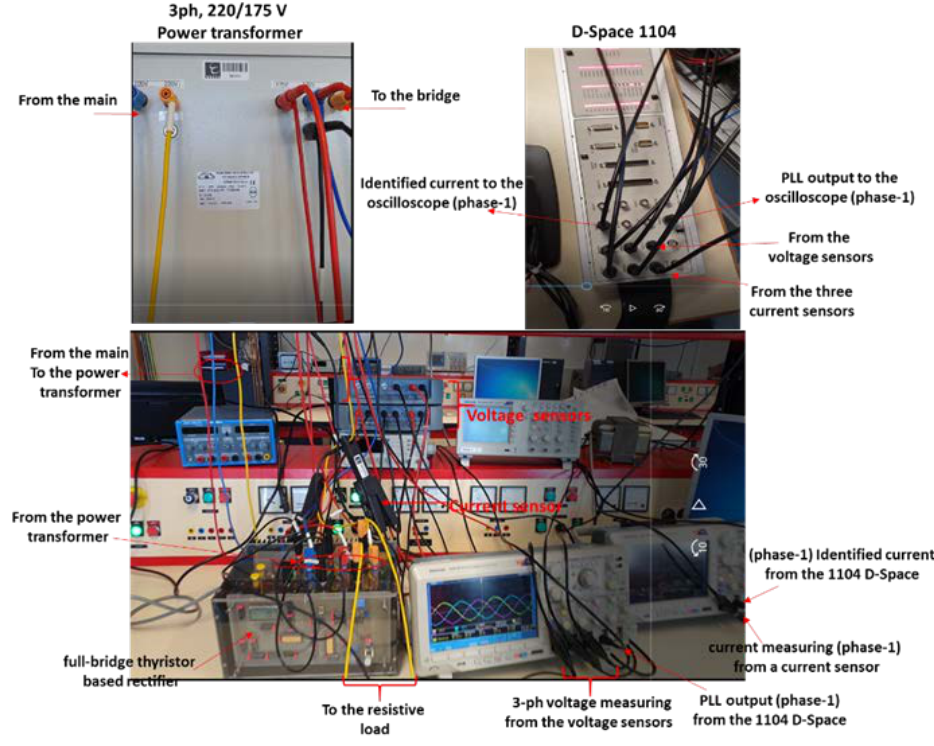
Figure 13. Experimental bench of the generalized identification method.